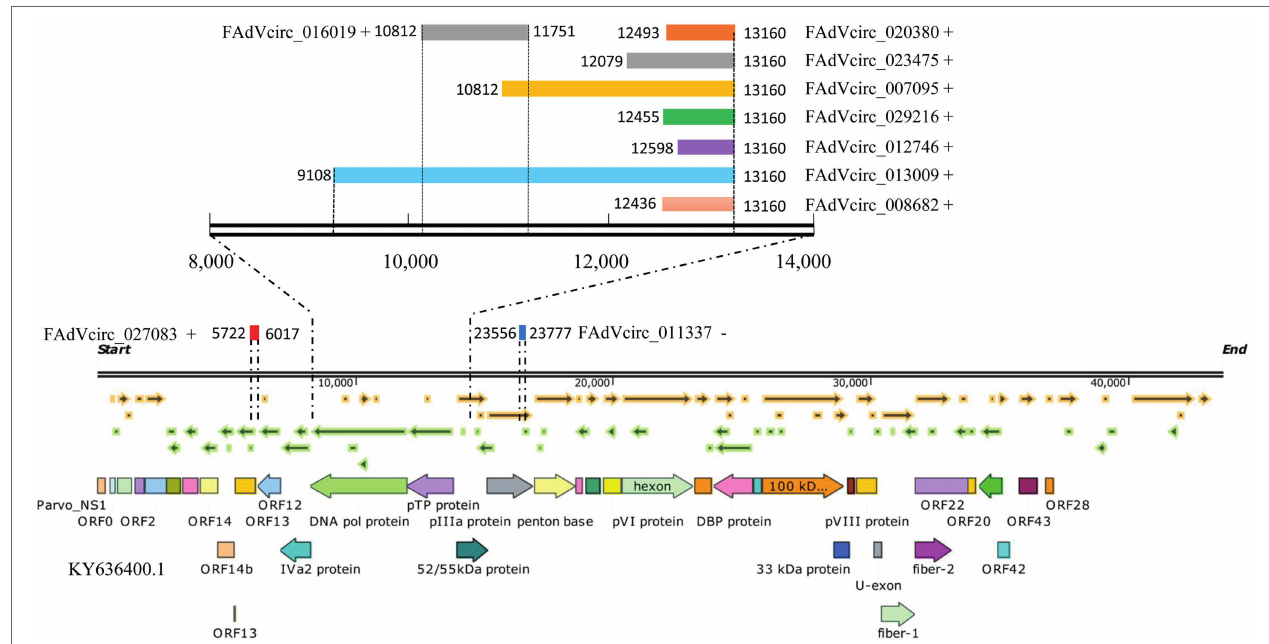
FIGURE 7 | The positions of FAdVcircRNAs in the FAdV-4 genome. The symbol “+” “ − ” represents the distribution of FAdVcircRNA on the sense or antisense strands. The colored rectangle represents the position of circRNA in the genome, and the numbers on the left and right sides represent the position of the starting point and the ending point in the genome, respectively. The figure below represents the genomic structure of FAdV-4.